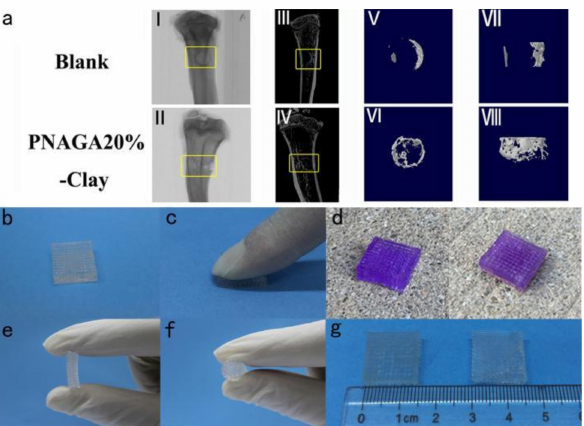
Figure 6. Characterization of implants and new bone formation by micro-CT ( a ( I , II )), micro-CT recon- struction images ( a ( III , IV )), and reconstructed 3D models ( a ( V – VIII )) of the new bones. Sequential fluorescent labeling blank photographs of PNAGA20%-Clay scaffolds showing their ability to resist finger compression ( b , c ), car wheel pressing ( d ), left and right denote before and after pressing), and hand folding ( e , f ). The scaffold is very stable even after immersing in water for a long time ( g ), left and right denote before and after water immersion for 3 months)